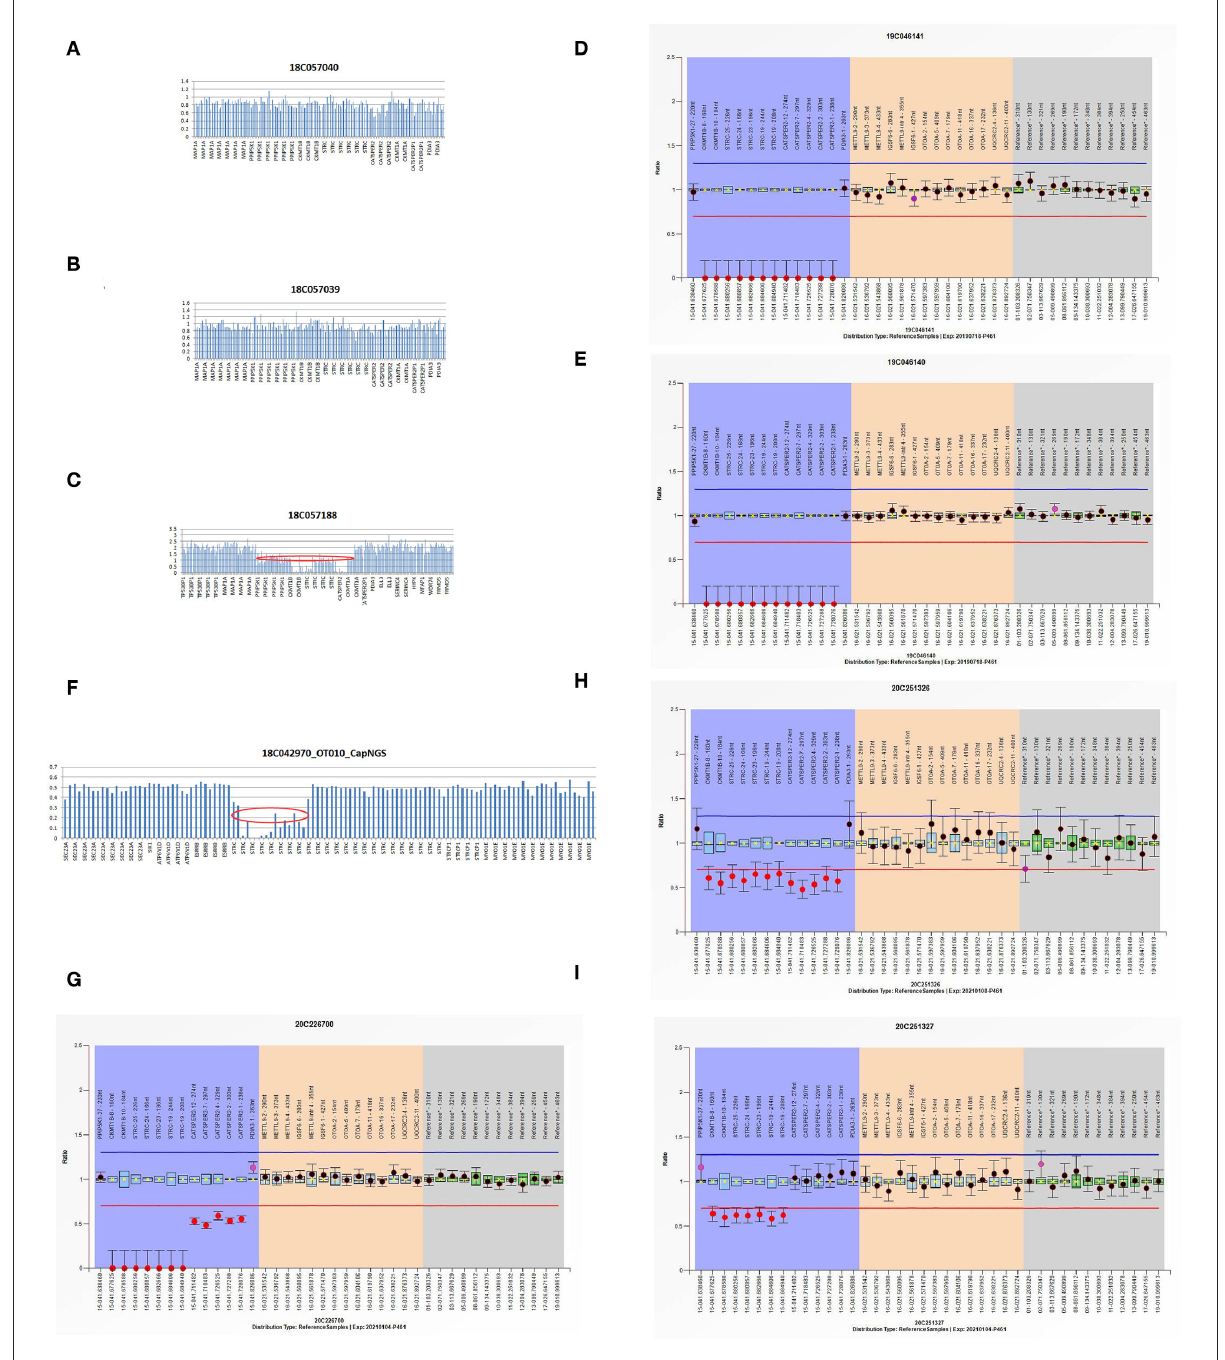
FIGURE3 (A–C ) The WES results of I:1, I:2, and II:1 in HL6 family. (D,E) The MLPA results of II:1 and II:2 in HL6 family. (F) The NGS result of HL7 proband. (G–I ) The MLPA results of II:1, I:2, and I:1 in HL7 family.